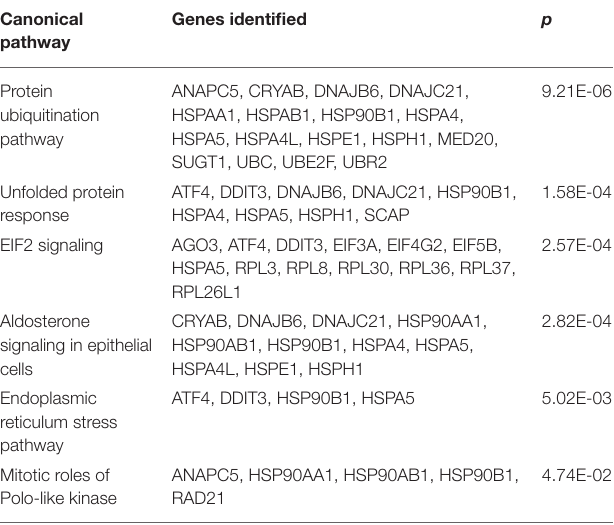
TABLE 2 | Functional annotation analysis of differentially expressed gene modules. Canonical